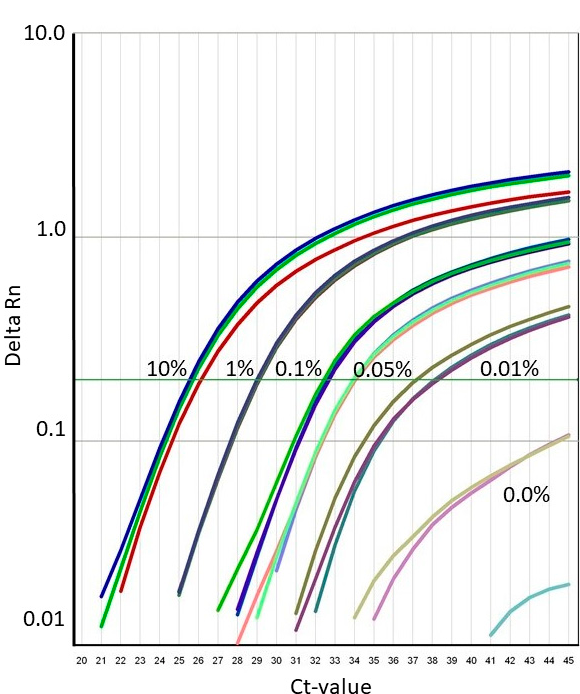
Figure 6. Typical amplification curves for the results shown in Table 3 of SU canola DNA variety 40K mixed at five concentrations with Clearfield canola DNA variety 5545